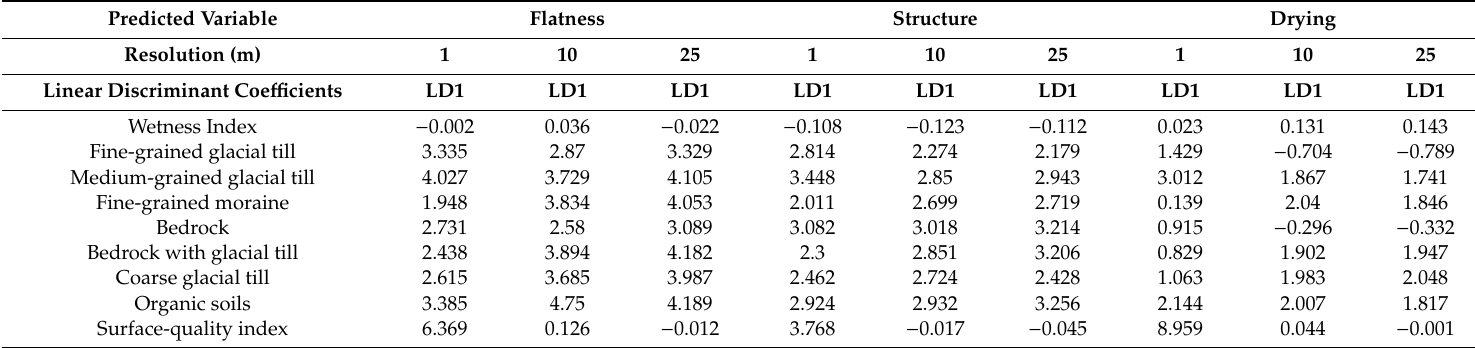
Table 6. Combination of the coe ffi cients for each linear discriminant based on a Linear Discriminant Analysis for a two-class classification. Three road-quality criteria (flatness, structure and drying) were predicted by using the wetness index, the surface-quality index and di ff erent soil types. Each predictor was calculated at three resolutions: 1, 10 and 25 m. LD1: first linear